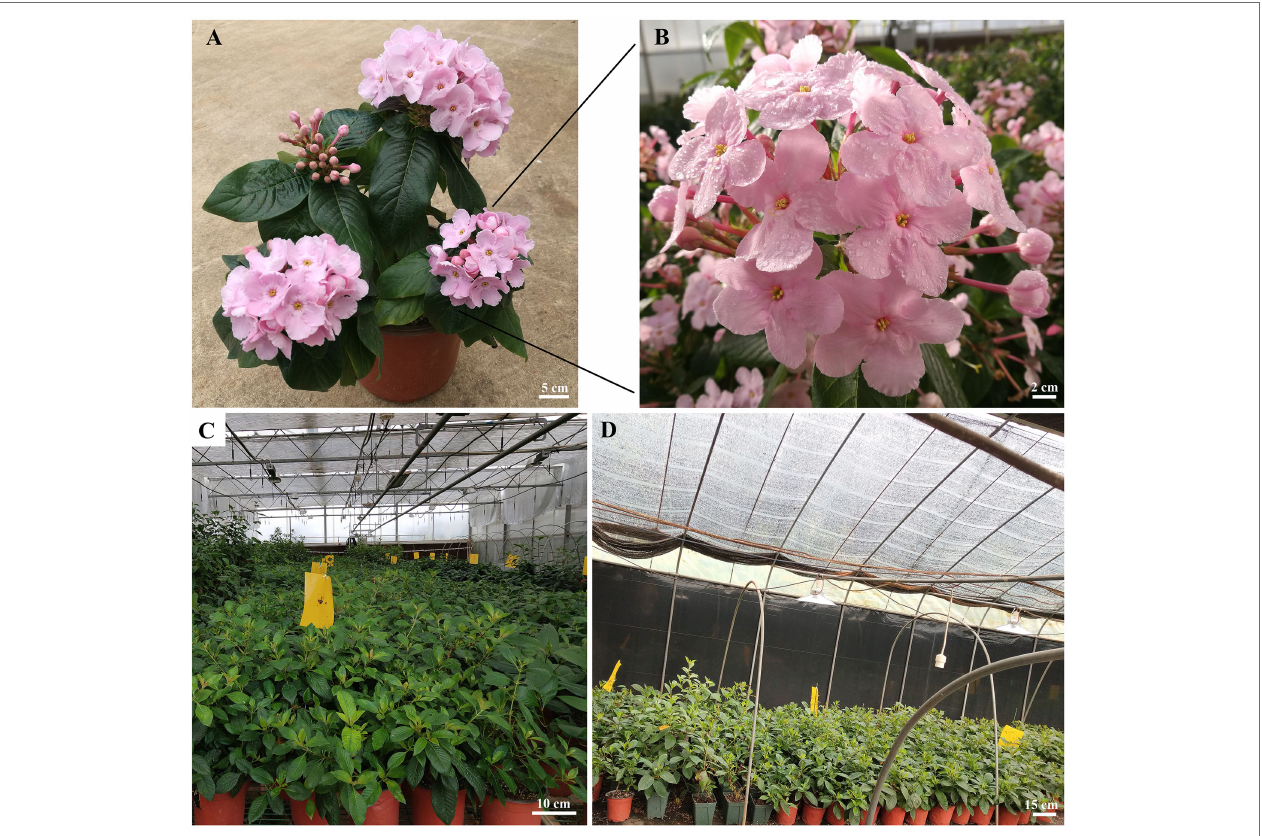
FIGURE 1 | Features of Luculia gratissima “Xiangfei” and the overview of greenhouses under two different photoperiods. (A) Whole plant of L. gratissima “Xiangfei.” (B) Flowers of L. gratissima “Xiangfei.” (C) Greenhouse under night-break treatment. (D) Greenhouse under short-day